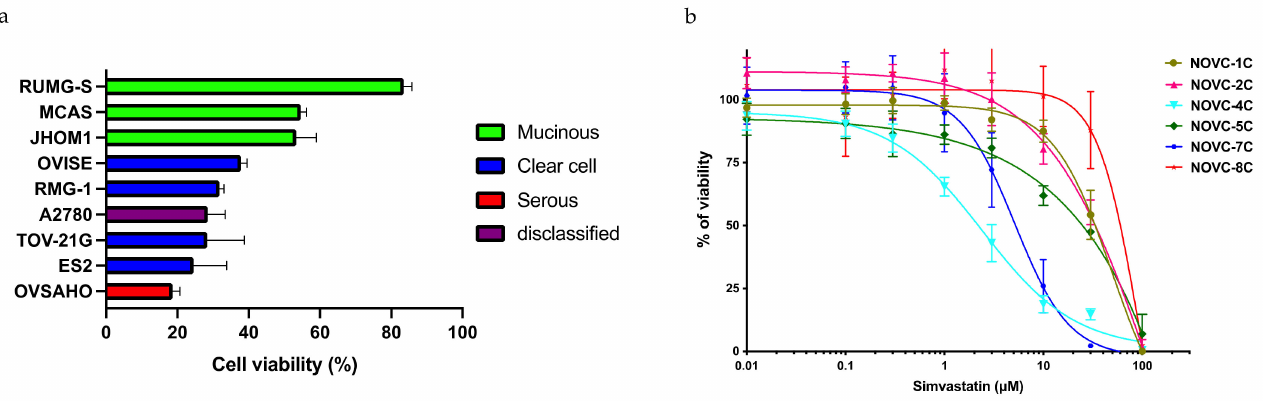
Figure 2. Response to simvastatin in existing cell lines and human ovarian cancer ascites-derived cell lines. ( a ) Cell viability of nine existing ovarian cancer cell lines (RUMG-S, MCAS, JHOM1, OVISE, RMG-1, A2780, TOV-21G, ES-2, and OVSAHO) after 72 h of simvastatin (10 µ M)-mediated culture ( n = 3). The cell lines are color coded as per histopathological type: red for serous carcinoma, blue for clear cell carcinoma, green for mucinous carcinoma, and purple for disclassified. ( b ) Cell viability of cell lines established from human ovarian cancer ascites (NOVC-1C, 2C, 4C, 5C, 7C, and 8C) after 72 h of simvastatin-mediated